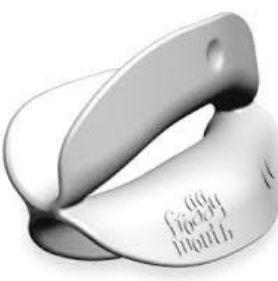
Figure 1. Froggy Mouth (FM) (Micerium, Genoa, Italy).